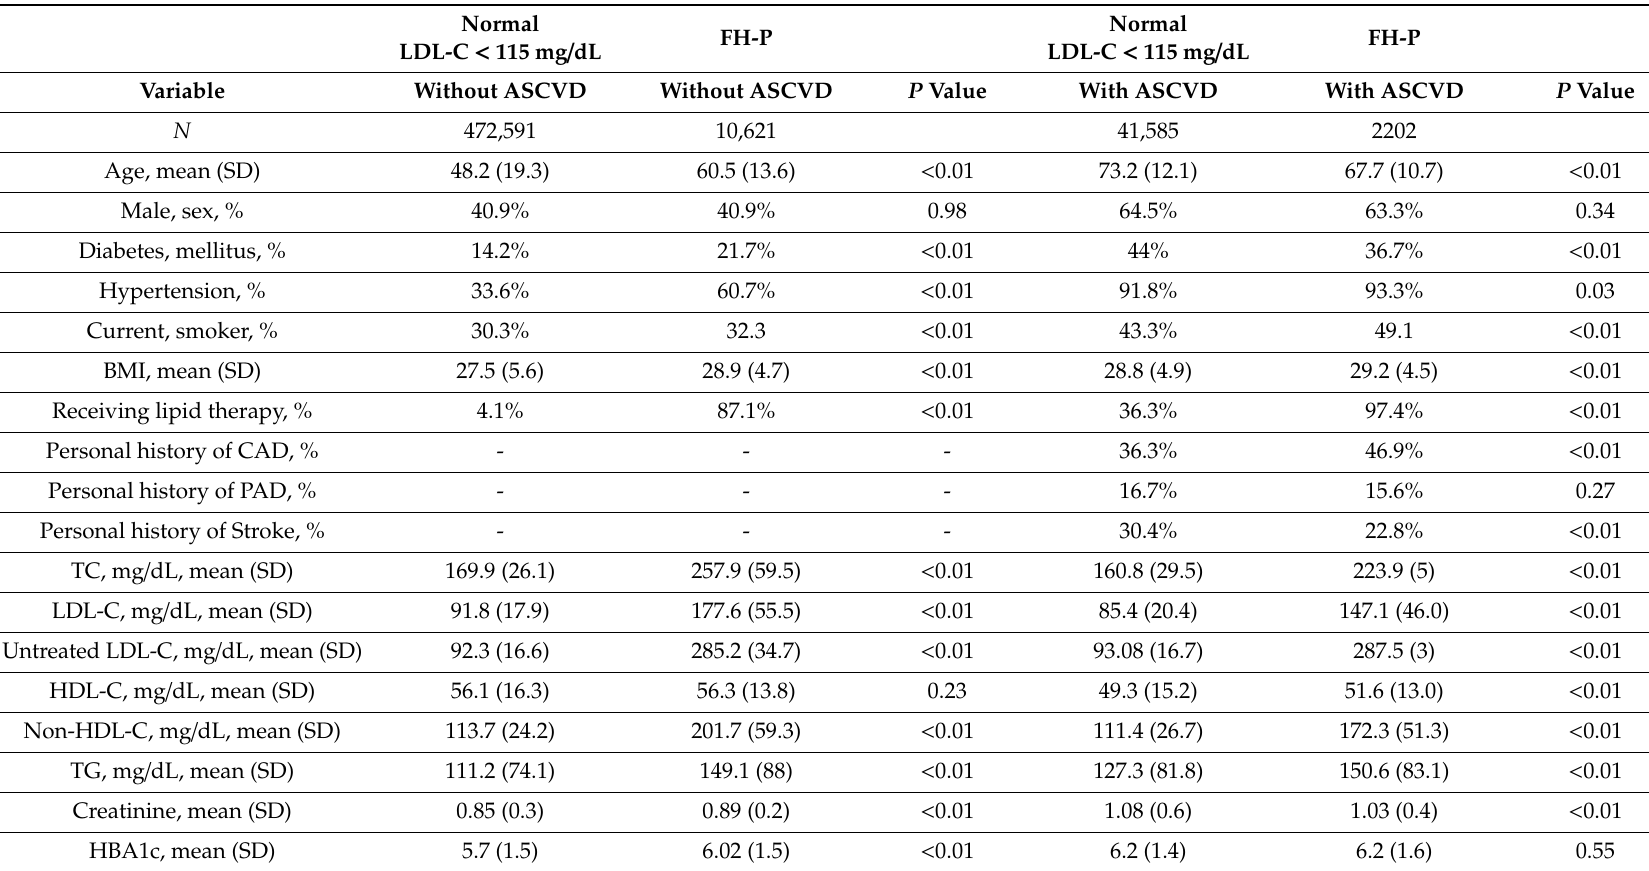
Table 1. Baseline characteristics of the study population according to the presence of familial hypercholesterolemia phenotype (FH-P) and previous arteriosclerotic cardiovascular disease